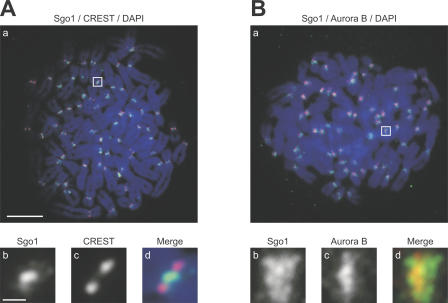
Immunofluorescent Staining of Chromosome Spreads from HeLa CellsChromosome spreads were stained for Sgo1 with antibody 94 (shown in green), and counterstained with (A) CREST antiserum (bar = 10 μm), and (B) antibody to Aurora B, (both shown in red). DNA was stained with DAPI (shown in blue). Enlarged views show a single Sgo1 focus located between two sister CREST dots (A), and overlapping with Aurora B focus (B). Bar = 1 μm [applies to images b–d in (A) and (B)].